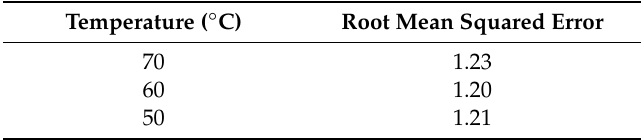
Table 2. RMSE analysis between experimental and theoretical